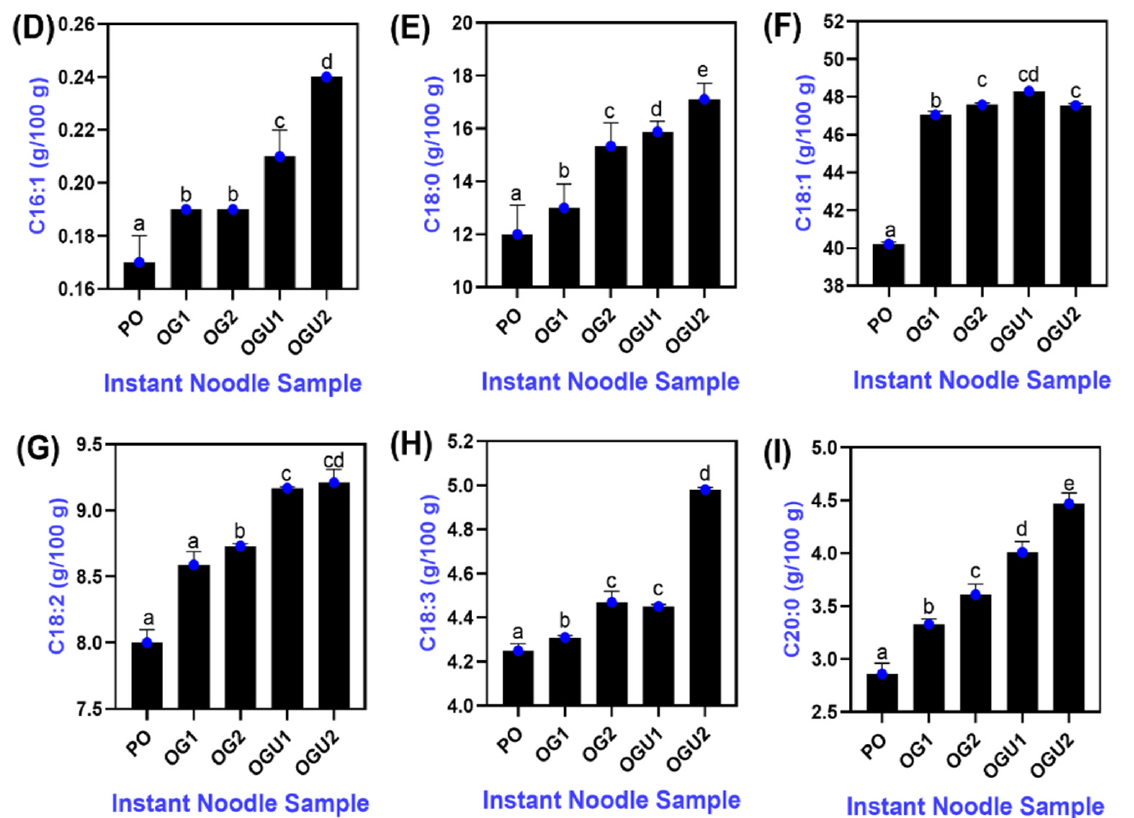
Figure 5. Fatty acid profile ( A – I ) of the surface of SDEW instant noodles that are fried using palm oil, palm oil–carnauba wax oleogel and palm oil–carnauba wax oleogel with ultrasonication treatments. Note: PO represents palm oil; OG1 represents palm oil–carnauba wax (5 g/100 g); OG2 represents palm oil–carnauba wax (10 g/100 g); OGU1 represents palm oil–carnauba wax (5 g/100 g) homogenized with ultrasonication; and OGU2 represents palm oil–carnauba wax (10 g/100 g) ho- mogenized with ultrasonication. The different alphabets (a–e, ab, cd) in the figures indicate signifi- cant differences.